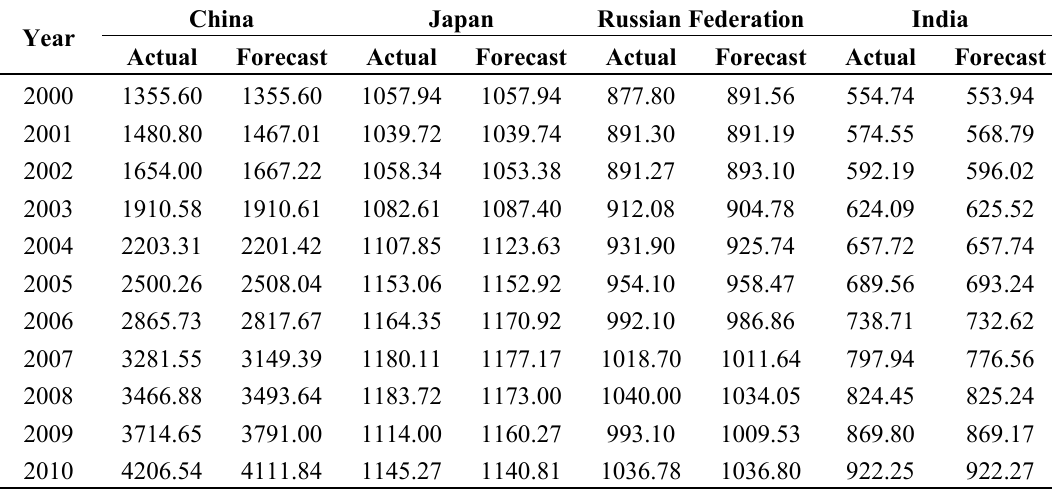
Table 2. Forecasting results of the HS-based JPOC model for four countries